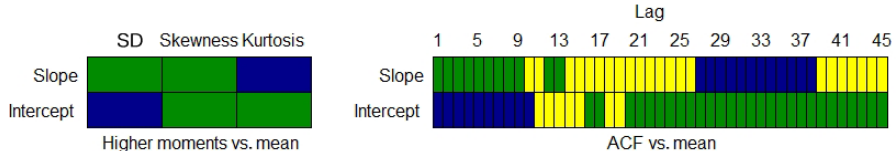
Figure 2. Overview of the relations between higher moments and sample autocorrelation function (ACF) of the daily NAO winter index on one hand and the sample mean for 71 winters on the other hand. As described in the captions of Figs. 1 and 3, we have performed ordinary linear regressions and calculated 95% confidence intervals for the intercepts and slopes of the regression lines. If a confidence interval is strictly positive, the corresponding field in the plot is blue, if a confidence interval is strictly negative, the corresponding field in the plot is green and if a confidence interval contains zero, the corresponding field in the plot is